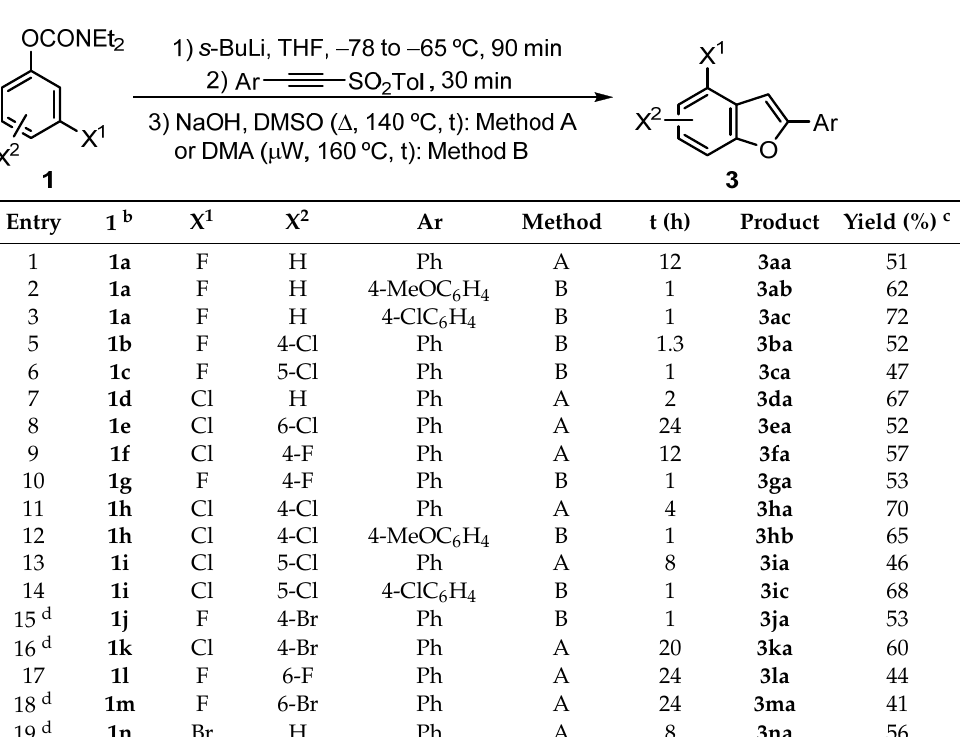
Table 3. One-pot reaction: Synthesis of 4, n -halobenzo[ b ]furans 3 from carbamates 1 a .